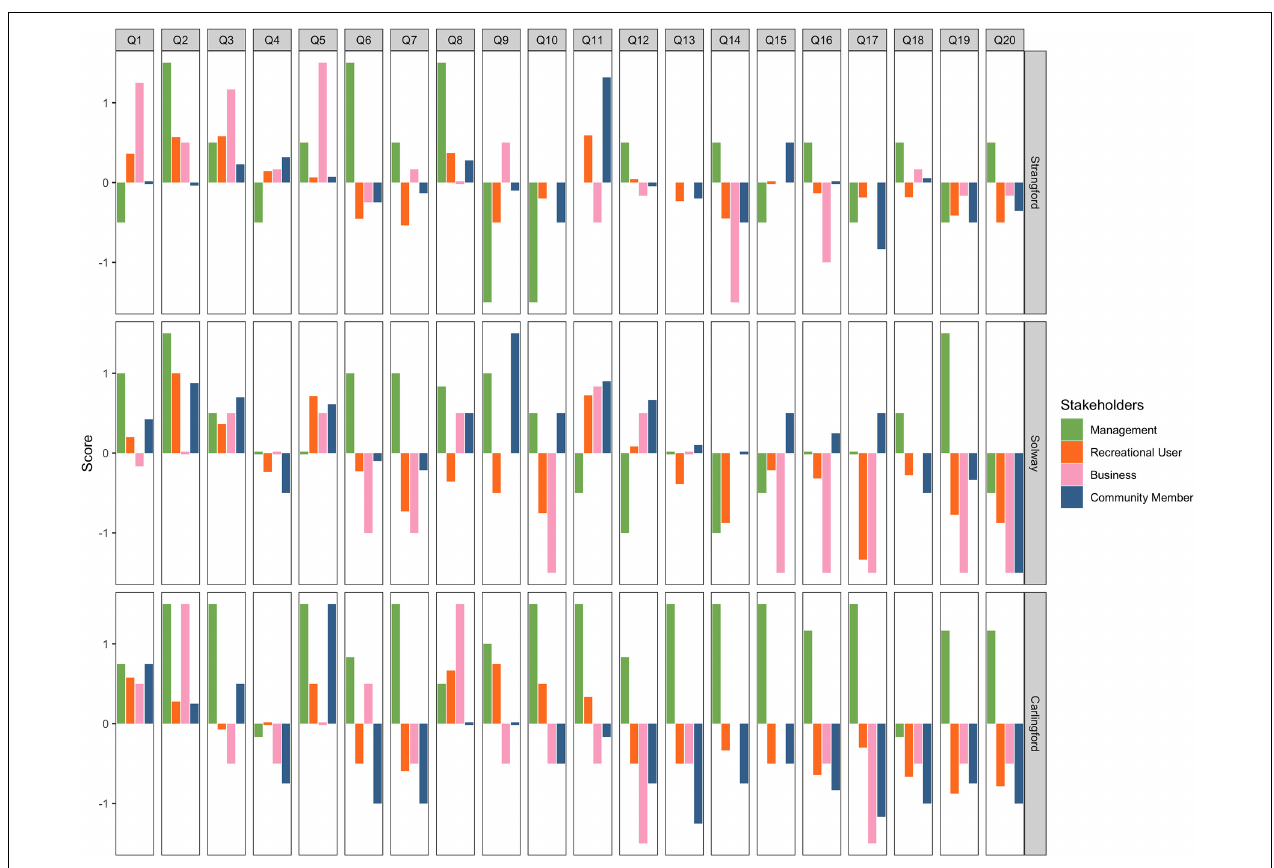
FIGURE 5 | Responses by stakeholder group (consolidated) and MPA across all case study